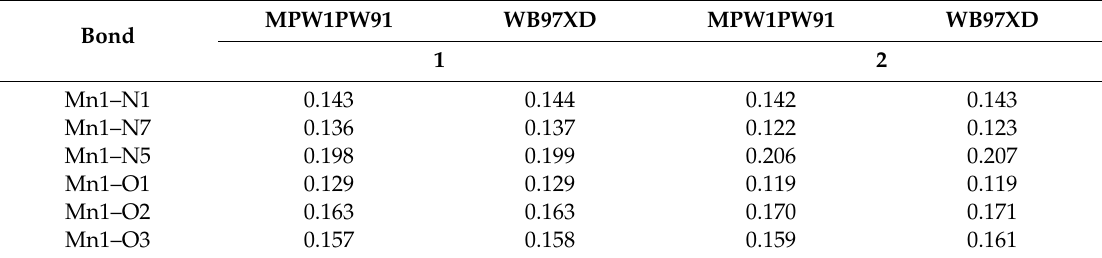
Table 6. Bond order analysis of the Mn–N and Mn–O coordination